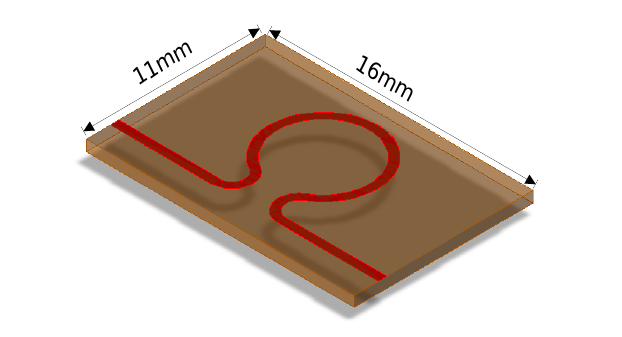
Figure 3: Interconnect microstrip line under test.